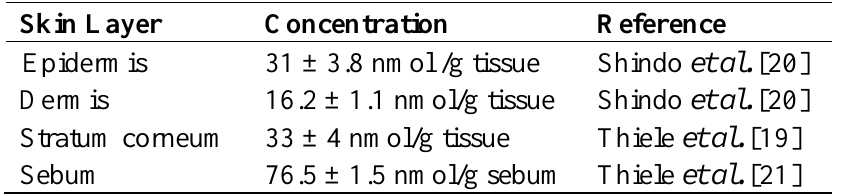
Table 1 . Distribution of α -Tocopherol in human skin